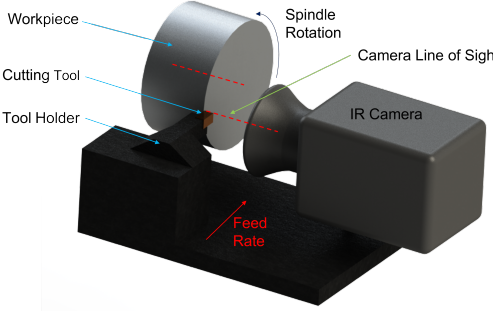
Figure 6. An illustration of a simplified typical infrared-camera